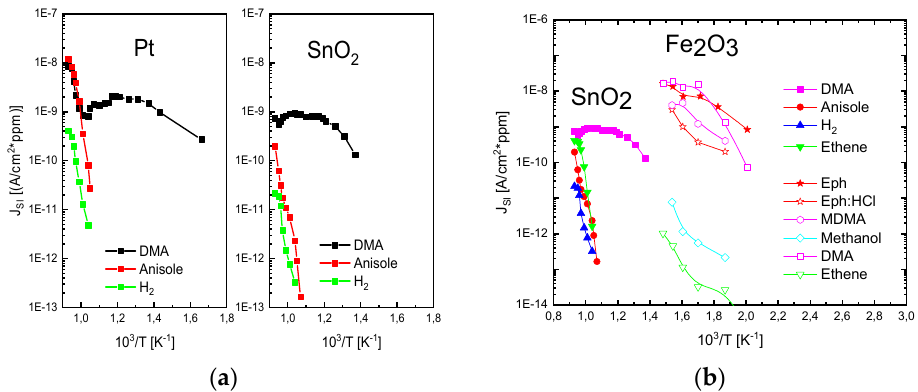
Figure 5. ( a ) SI ion current densities observed in vertical read-out structures as shown in Figure 4d. Emitters are thin-film Pt and SnO 2 obtained by the thermal oxidation technique; ( b ) SI ion current densities observed from emitters consisting of thermally oxidized SnO 2 and CVD-deposited Fe 2 O 3 [8–10,26]. All materials show a very pronounced amine selectivity.